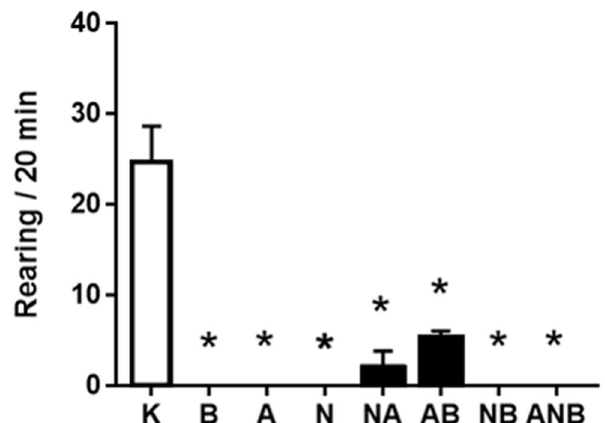
Figure 7. Rearing. The number of rearing induced by ketamine in the open field test (OFT), mean values and 95 percent confidence intervals are shown. In the ketamine rats (30 mg/kg ip), medication (mg/kg ip) was: L-NAME (5) (N), L-arginine (100) (A), BPC 157 (0.01) (B), alone and/or together (L-NAME+L-arginine (NA), L-arginine+BPC 157 (AB), L-NAME+BPC 157 (NB), L-arginine+L-NAME+BPC 157 (ANB)), and saline 5 mL/kg ip (control ketamine) (K). The application was immediately before ketamine (L-NAME, L-arginine, and combination) or the application was immediately after ketamine (BPC 157 and combinations). Dunnett’s multiple comparison test was used to compare control group (K) with treated groups.* p < 0.001 relative to ketamine.